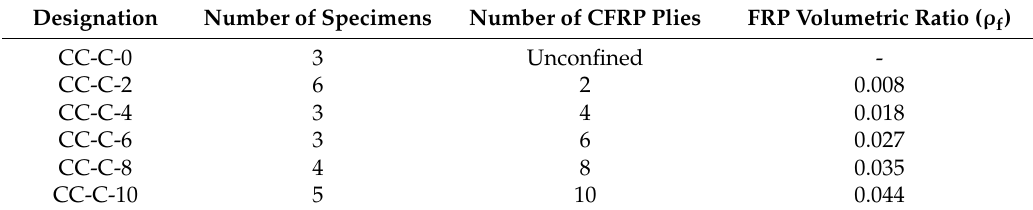
Table 1. Details of test specimens.